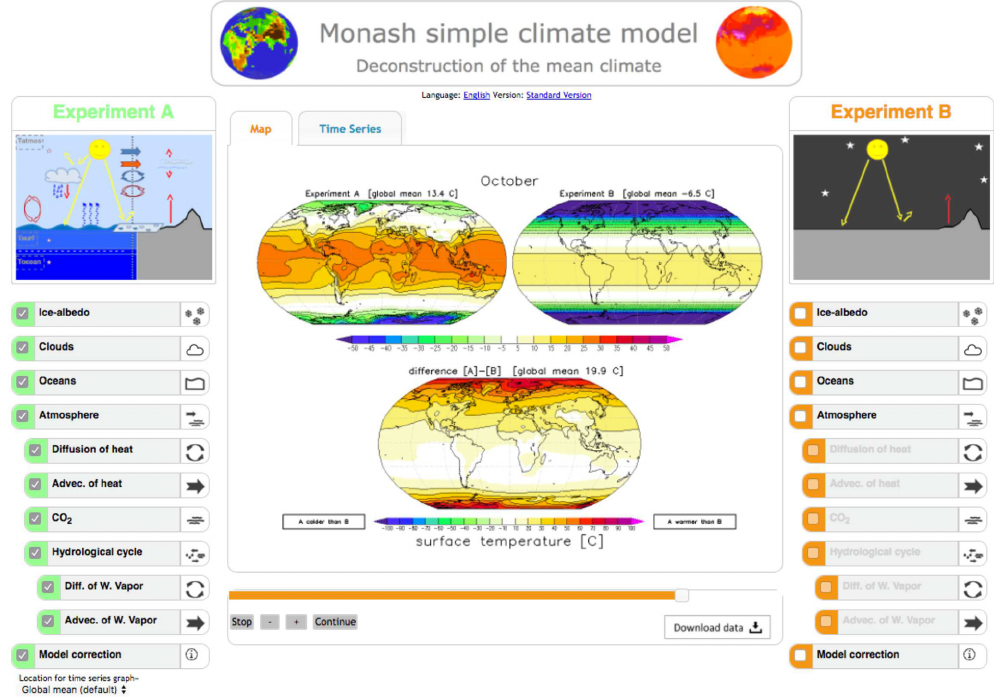
Figure 1. MSCM interface running the deconstruction of the mean climate experiments. Experiment A, on the left, has all processes turned ON, and experiment B, on the right, has all turned OFF. The T surf of experiment A is shown in the upper left map, experiment B in the upper right, and the difference between the two in the lower map. The example shows the values for the October